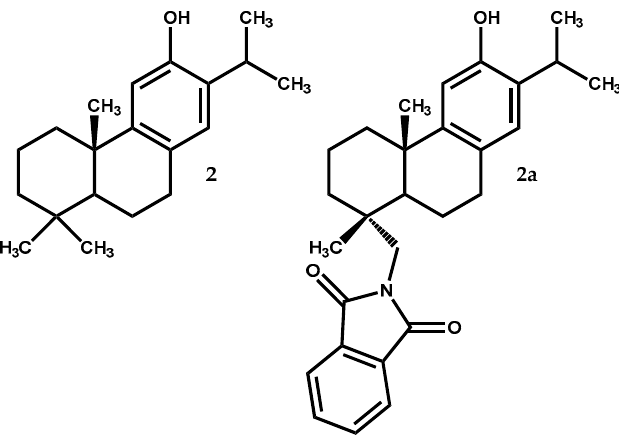
Figure 2. Ferruginol ( 2 ) from Juniperus species and the most active antiviral derivative ( 2a ).